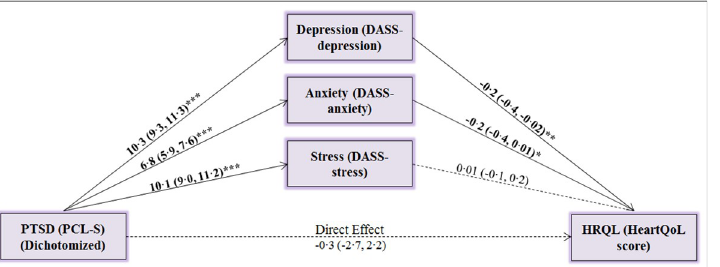
Fig 2. GSEM: The estimation of the direct and indirect effects of PTSD on HRQL. Covariates additionally adjusted for: Age, gender, occupation, education, residence, hospital, cardiac diagnosis, cardiac treatment, years with disease, somatic symptoms (PHQ-15), comorbidities, medications, body mass index, physical activity, smoking status. Follow- up duration was also adjusted for with no differences in the results. Bolded lines indicate statistically significant effects and dashed lines indicate non-significant effects. Each line is labeled with the respective effect estimate and its 95%- confidence intervals. Note that because the scales of the three mediating variables are not the same, the effect sizes cannot be compared directly. Follow-up for HRQL: (n = 622). PTSD = Post-Traumatic Stress Disorder, PCL-S = Post- Traumatic Stress Disorder Checklist, DASS = Depression, Anxiety, Stress Scale, HRQL = Health-related quality of